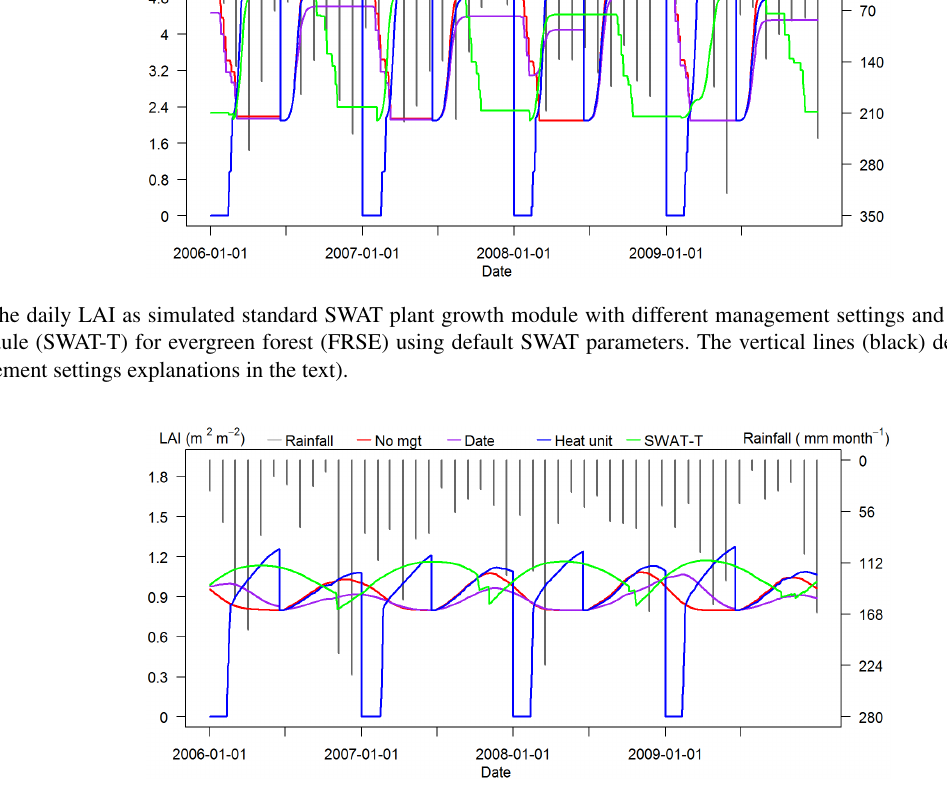
Figure 5. The daily LAI as simulated standard SWAT plant growth module with different management settings and by the modified plant growth module (SWAT-T) for grass (RNGE) using default SWAT parameters. The vertical lines (black) denote monthly rainfall (see man- agement settings explanations in the